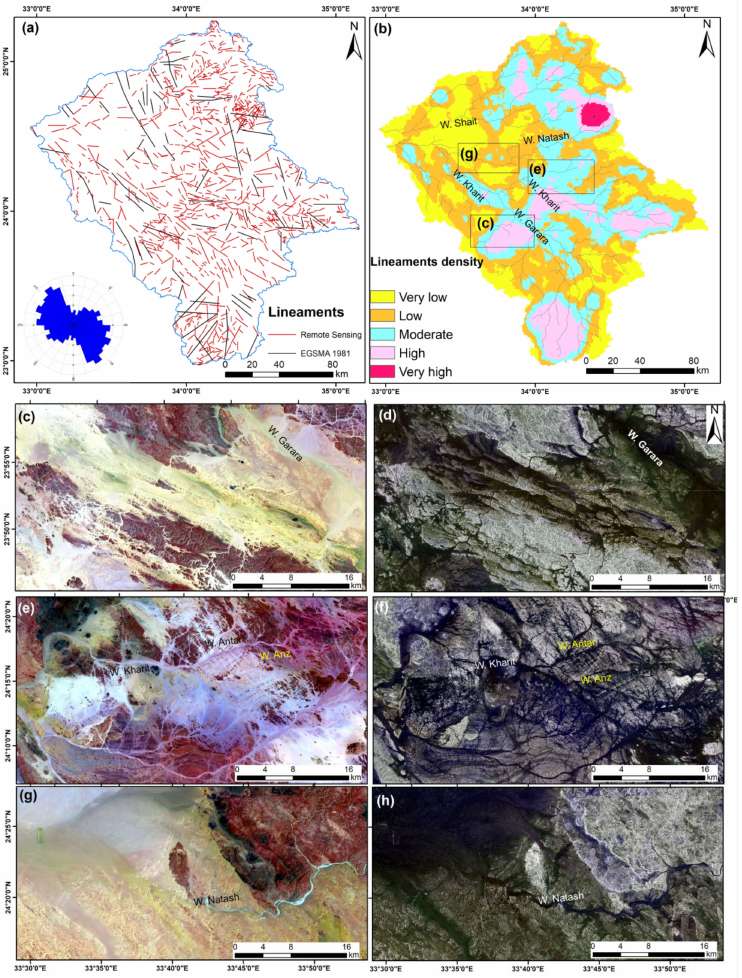
Figure 10. ( a ) Lineaments derived from remotely sensed data and a geological map [26]; ( b ) lineament density map; ( c ) Landsat-8 image of W. Gara; ( d ) a fused ALOS/PALSAR and Landsat-8 of the same area as in ( c ), the NW–SE trend is cut by the NE–SW trend; ( e , f ) highly altered and dissected crystalline rocks of Kharit upstream; ( g , h ) paleochannels of the downstream of W. Natash that are difficult to reveal in Landsat-8 in ( g ) are revealed in a fused ALOS/PALSAR and Landsat-8 ( h